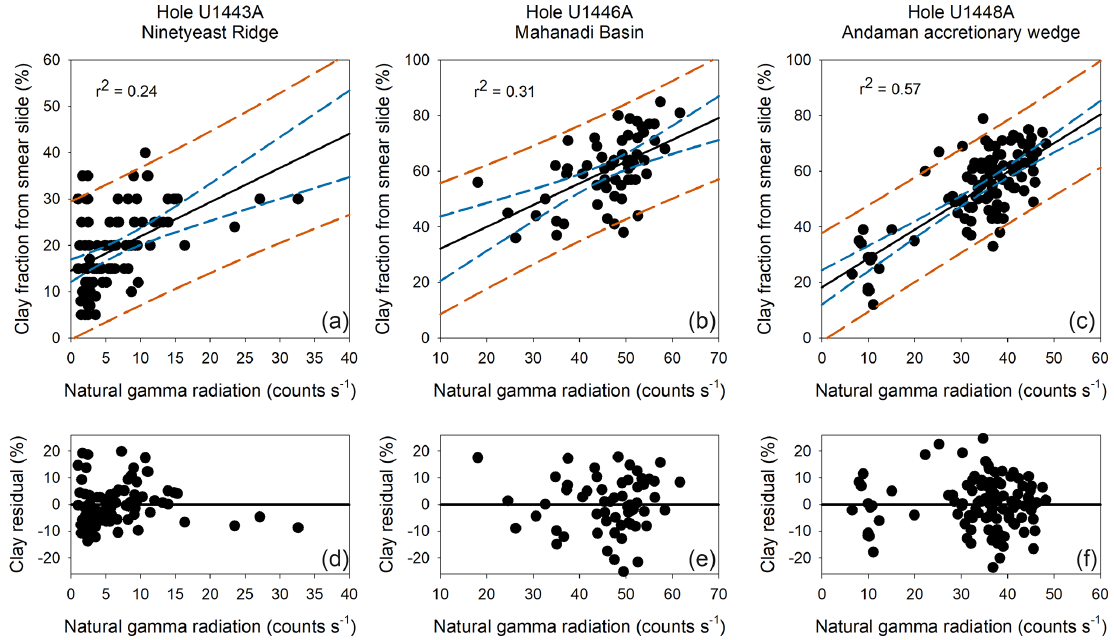
Figure 7. Cross plots of natural gamma radiation vs. estimates of clay minerals from smear slide, where the measurements are within 5cm of each other in the core. (a) IODP Site U1443, (b) IODP Site U1446, and (c) IODP Site U1448. Grey solid lines are best-fit linear regression, teal dashed lines are 95% confidence intervals, and red dashed lines are 95% prediction intervals. Panels (d) , (e) , and (f) show the residuals around the best-fit line for Sites U1443, U1446, and U1448, respectively.